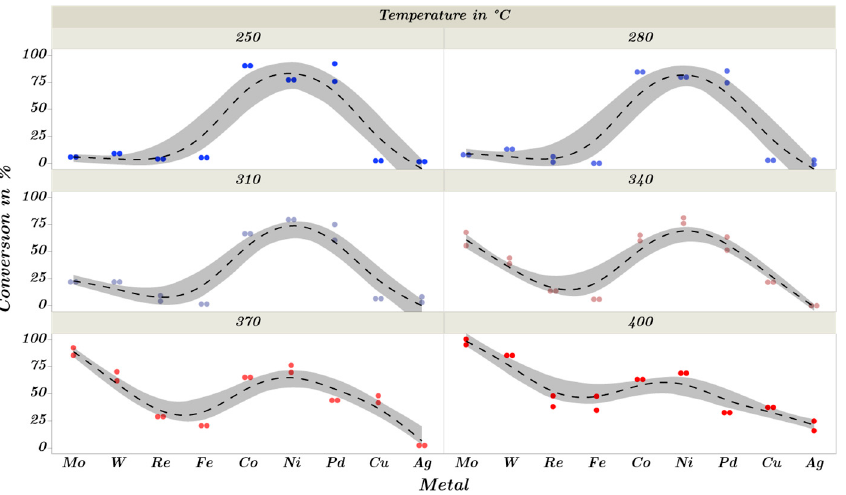
Figure 11. Summary of the conversion curves in the test measurements of the metal-silica catalyst systems. The dashed smoothing is based on a spline with λ = 0.05 and the confidence interval.